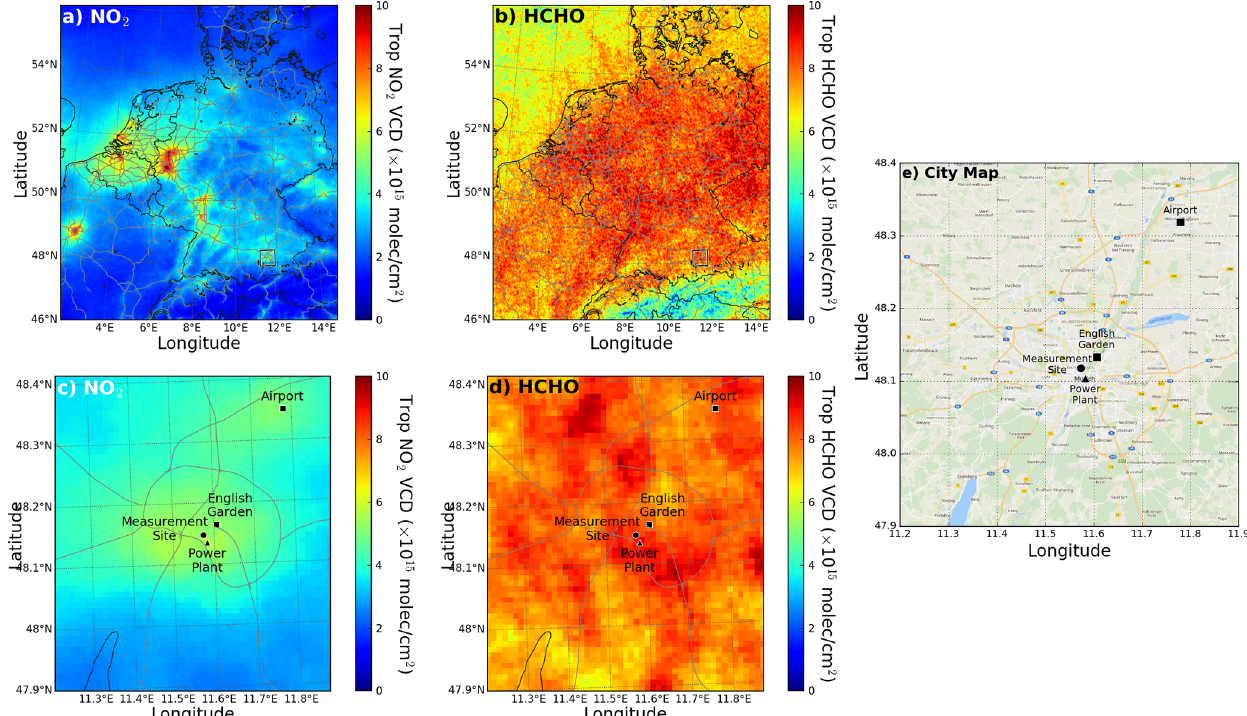
Figure 3. Annual average TROPOMI tropospheric (a) NO 2 and (b) HCHO VCDs over Germany and its surrounding regions. Zoomed-in maps of (c) NO 2 and (d) HCHO over Munich are also shown in (c) and (d) , respectively. Data from May 2018 to April 2019 are used in the calculation of average maps. Values above or below the range of the color scale are set to the maximum or minimum value of the color scale. Panel (e) shows the city map of Munich, and the base map is taken from © Google Maps (https://www.google.com/maps/).